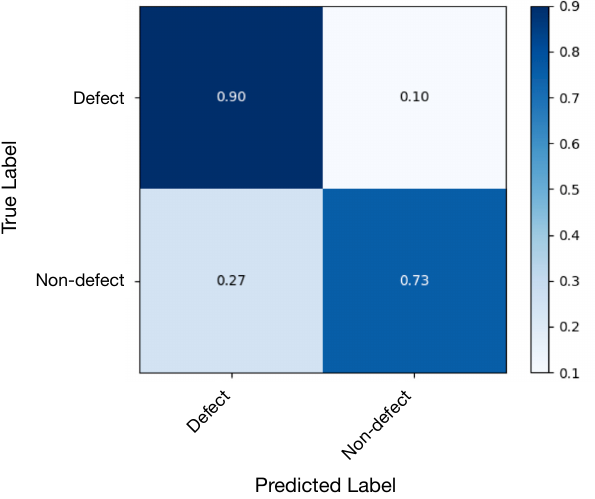
Figure 16. Confusion matrix for classification results of fruit quality on Apple-NDDA dataset